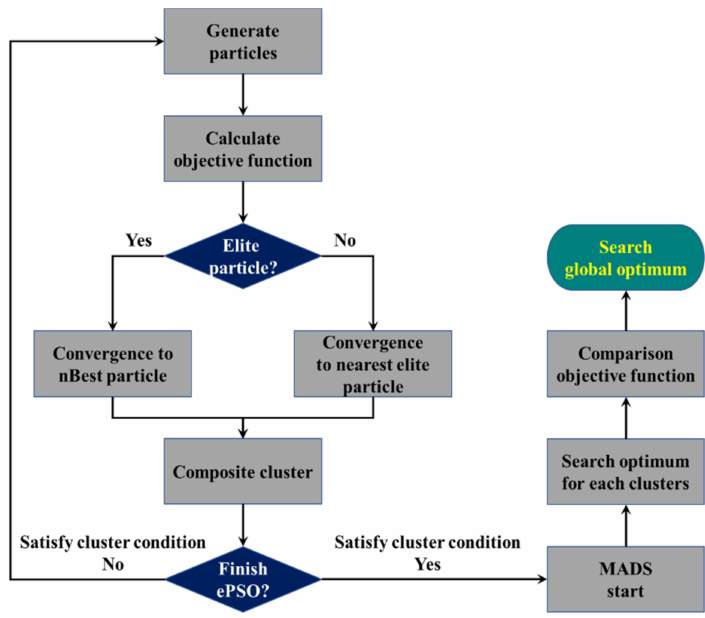
Figure 1. The flow chart of ePSO.